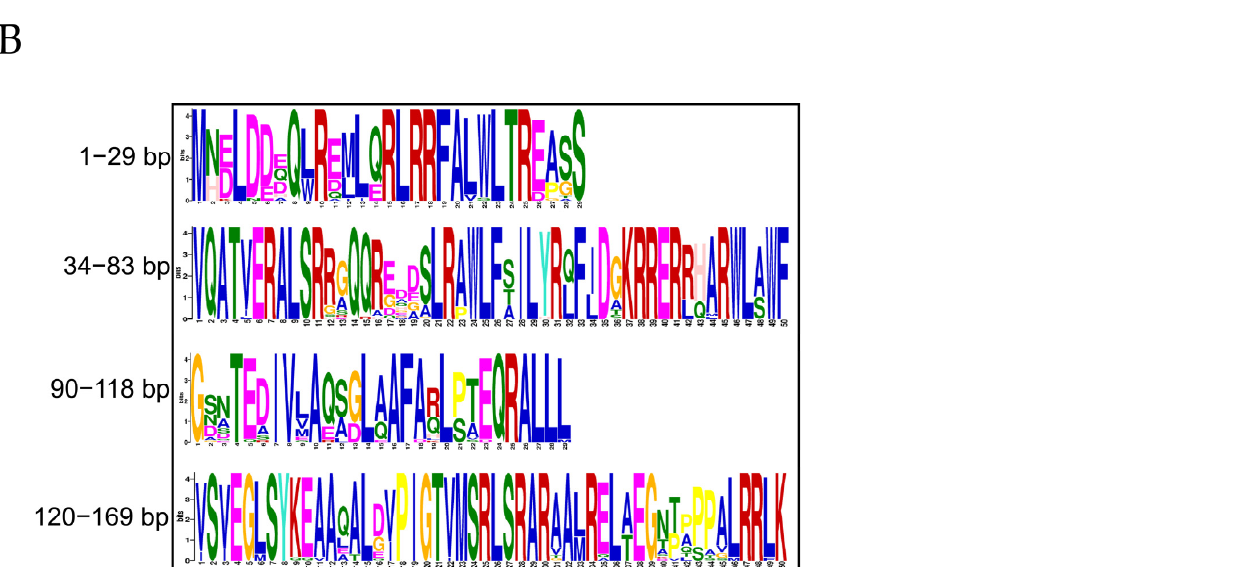
Figure 7. Genetic organization and characteristics of the sigW operon. ( A ) The 5 ′ -RACE method was used to identify the TSS of the sigW operon using RNA sample, with the − 10 and − 35 motifs then deduced afterwards. The red triangle represents the start codon. The genes are drawn to scale. ( B ) MEME online prediction of the conserved motifs of SigW. The seqlogo plot shows how well the motif is conserved at each position; the higher the letter, the better the position is conserved. Different amino acids in the same position are scaled according to their frequency. The rules for construction logos are given B–C or G or T, Y–C or T, S–G or C, D–A or G or T, W–A or T, K–G or T. This graph